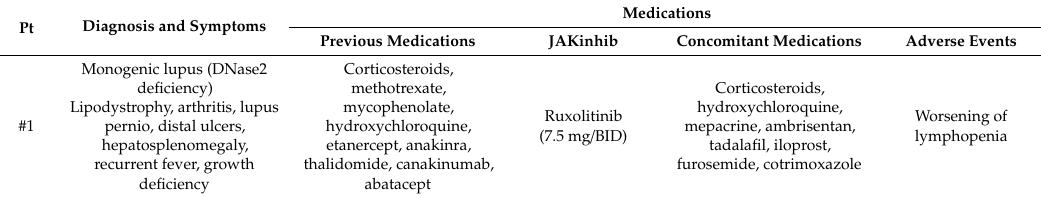
Table 1. Characteristics of the patients and